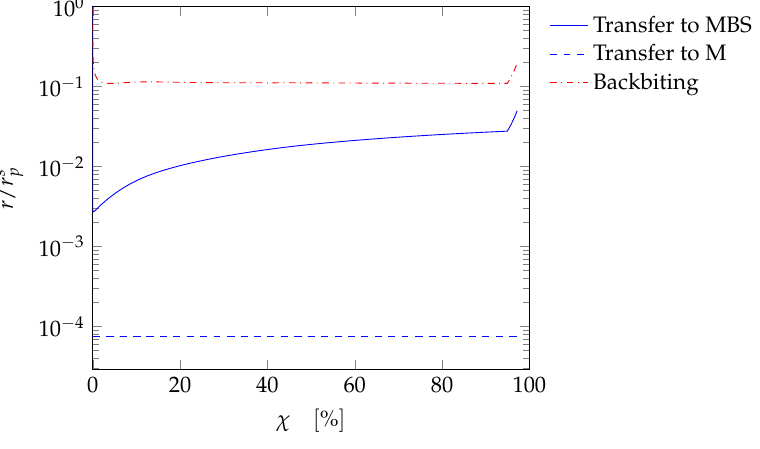
Figure 7. Ratio of selected reaction rates to the propagation rate of terminal radicals as a function of conversion for case